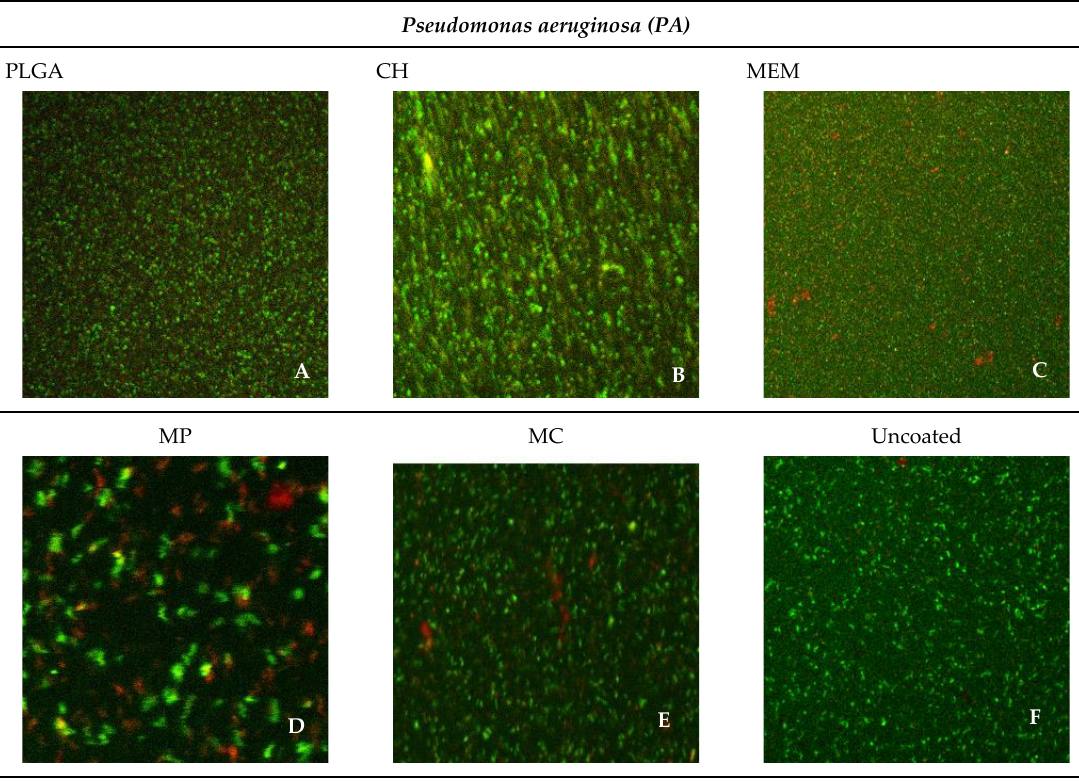
Table 4. Showing the Percentages of live bacteria among the different materials against SA and PA using the confocal microscope. Material